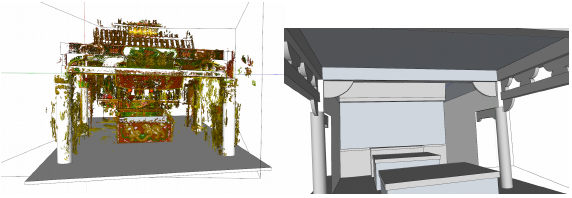
Figure 1. Point clouds of a Chinese style Land God shrine and its reconstructed bare-bones volume